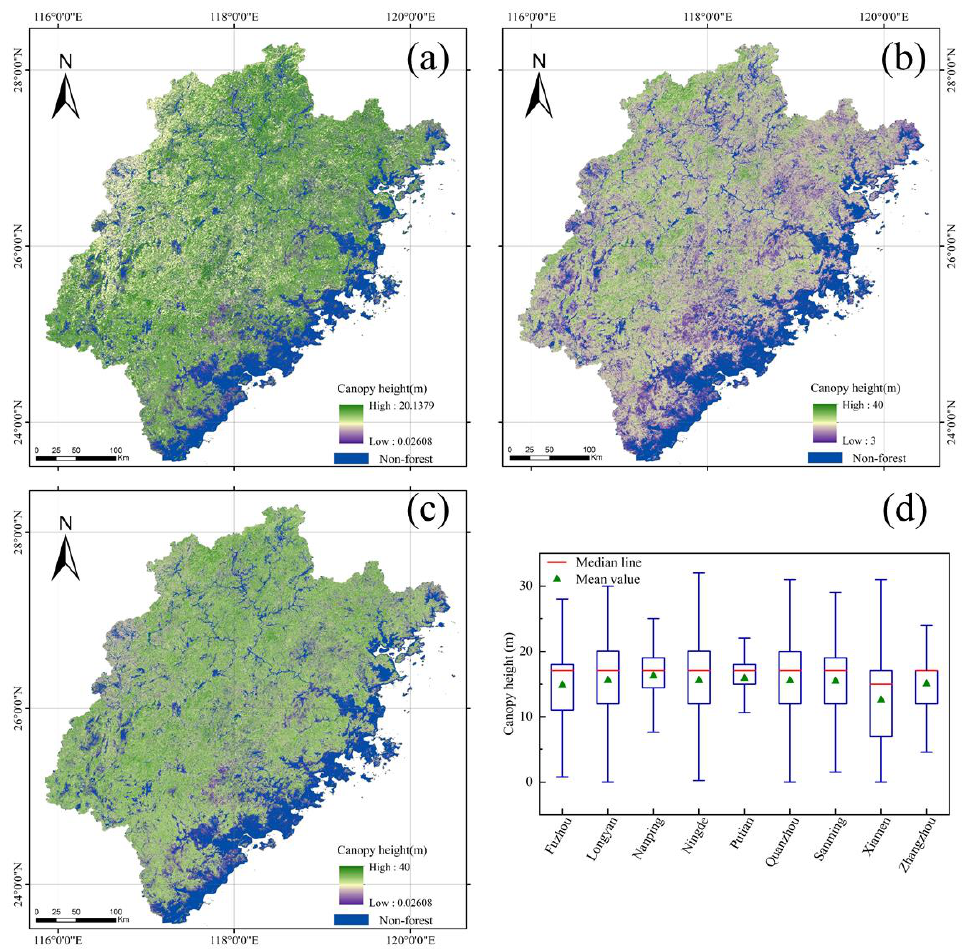
Figure 12. Canopy height estimation results. ( a ) Canopy height of Fujian estimated from time-series optical images. ( b ) The GEDI_V27 for the Fujian region. ( c ) Canopy height distribution of the MGEDI_V27 in Fujian obtained by merging time-series optical remote sensing and the GEDI LiDAR data. ( d ) Boxplots of the MGEDI_V27 forest canopy height of Fujian grouped by city.